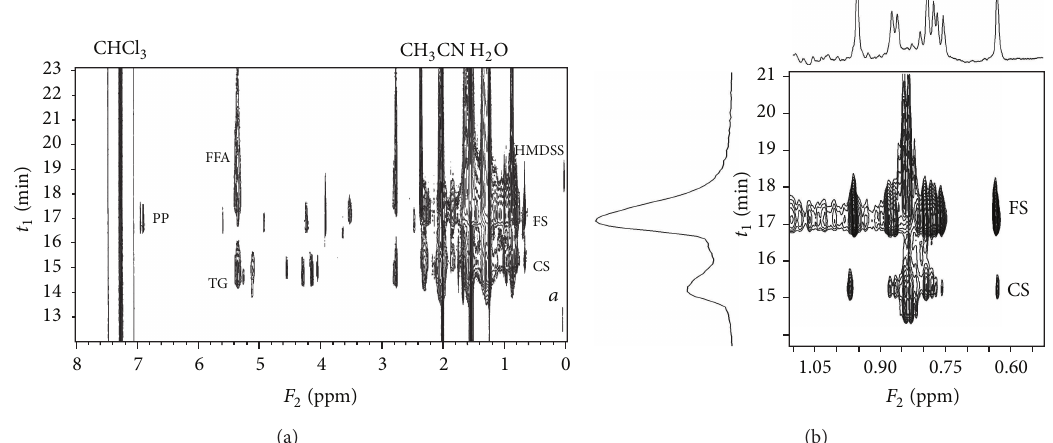
Figure 4: On-flow SEC-NMR measurement of the stinging nettle extract, whole spectrum (a) and a detail of the upfield region (b). FFA: free fatty acid, TG: triglycerides, PP: polyphenolic compounds, HMDSS: hexamethyldisilane, FS: free phytosterols, CS: conjugated phytosterols, and a : silicone